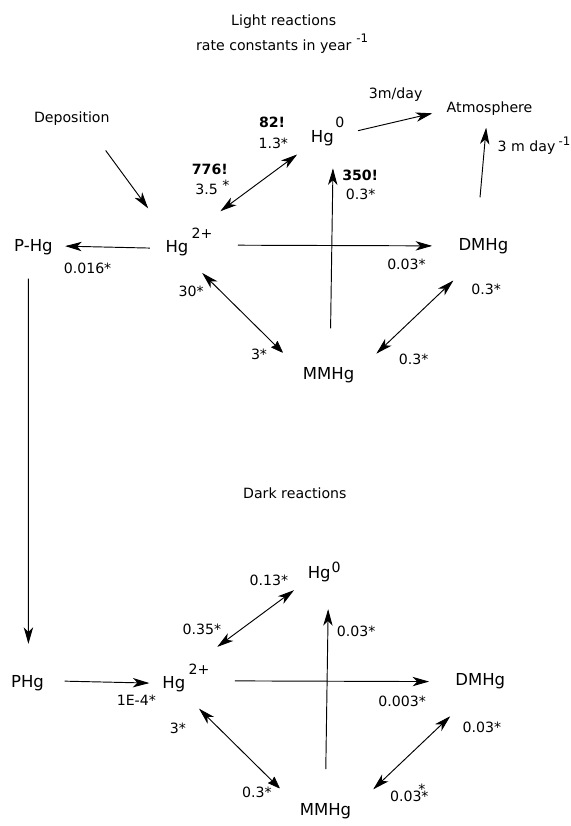
Figure 1. Schematic of the reaction web for Hg speciation in the model. Starred numbers by the arrows show typical values for bi- ologically mediated rate constants, measured as per year (yr − 1 ). Photochemical rate constants are denoted by bold text and excla- mation marks (!). Gas evasion rate constants are based on an ocean- average piston velocity of 3mday − 1 (Broecker and Peng, 1974). Biological rate constants are fit to Semeniuk and Dastoor (2017) and Zhang et al. (2014a), based on first-order degradation kinetics for POC, resulting in a scaling k bio = 10 − 6 [POC](molL − 1 ). Pho- tochemical MMHg degradation rate constant is from Bergquist and Blum (2007). Hg(II) photoreduction and Hg(0) photooxidation rate constants are fits to the global budget from Soerensen et al.